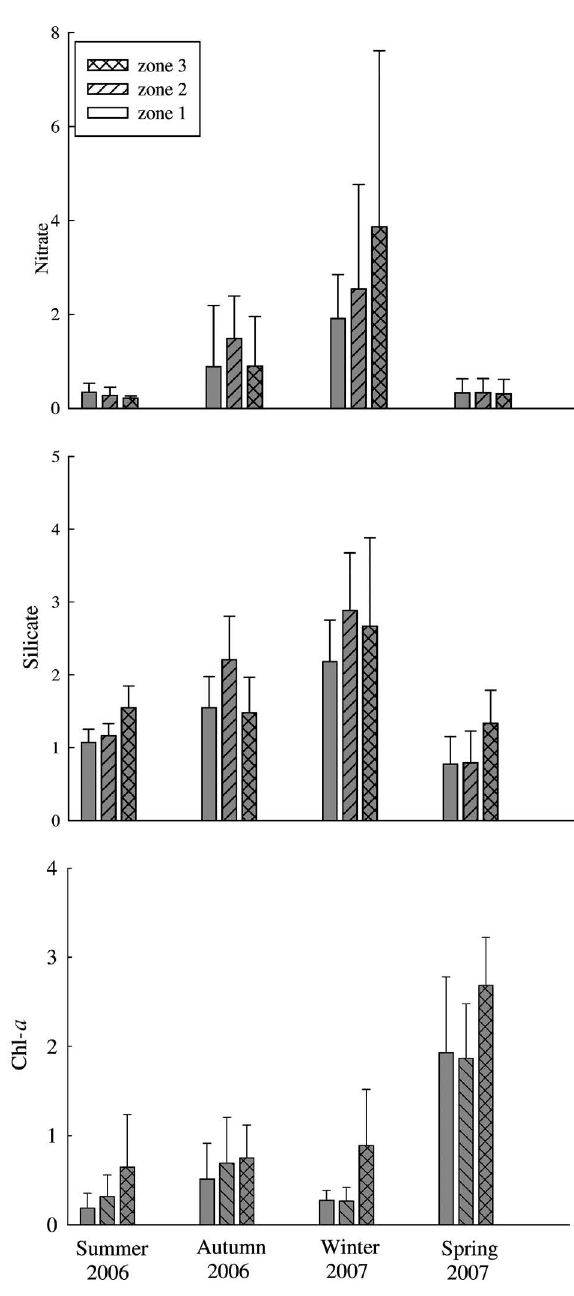
f ig . 7. – Seasonal average values of nitrate (µM), silicate (µM) and chl- a (µg dm –3 ) between the sea surface and nitracline depth for the three zones. Zone 1 corresponds to the oceanic area while zones 2 and 3 indicate the south and north regions respectively (Fig.